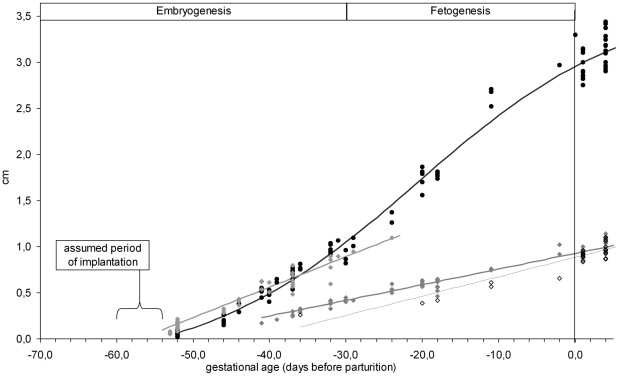
Prenatal growth in naked mole-rats.Biometric parameters (in cm) are displayed as a function of gestational age. Dots represent the data points and lines the regression curves (equations are given in the text). Light grey = mean diameter of the embryonic vesicle (EV), black (thick) = crown-rump-length (CRL), dark grey = biparietal diameter, black (thin) = widest diameter of the thorax.